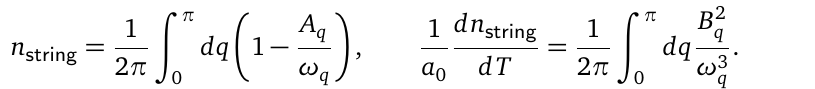
/ dT shows string